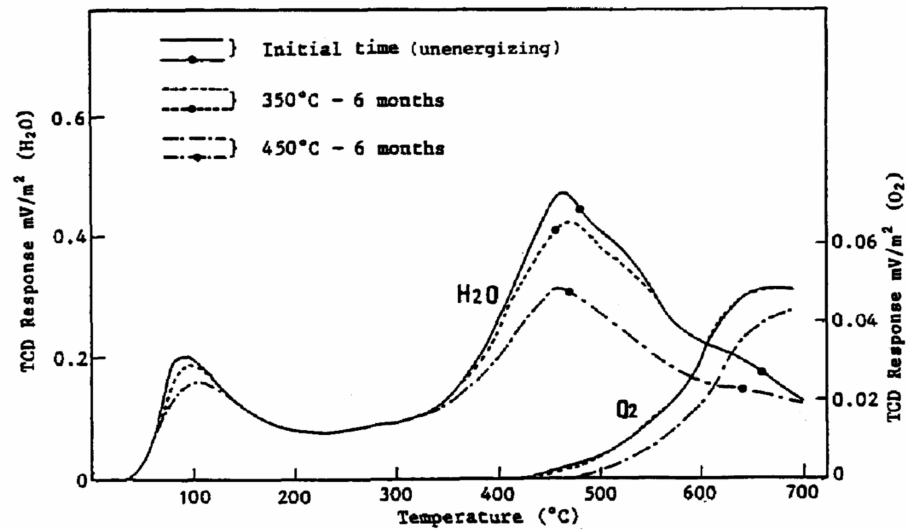
Figure 8. TPD chromatograms of H2O and O2 desorption from SnO2. Reproduced with permission from Reference